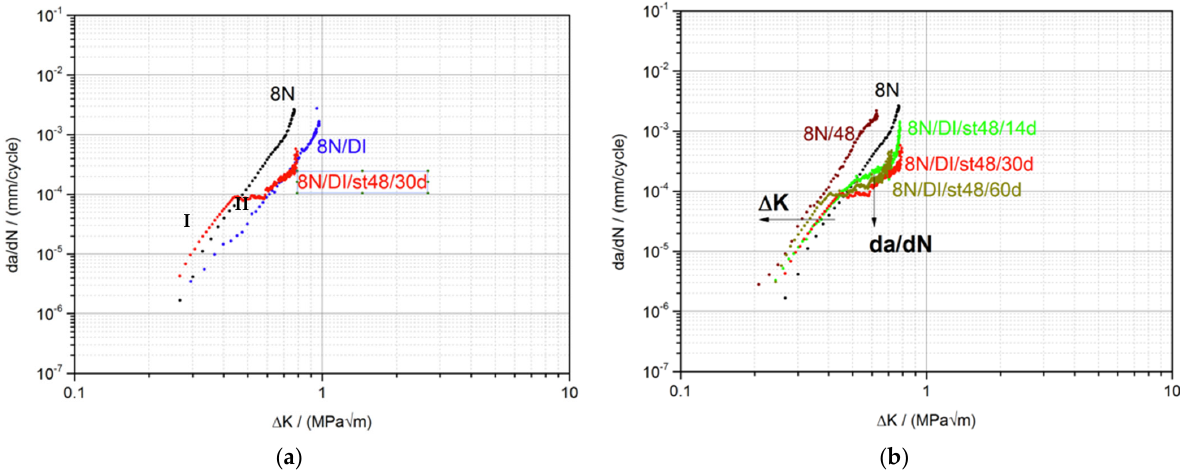
Figure 5. ESC behavior of PMMA after prior immersion and in situ wetting in DI ( a ) and influence of immersion time in DI on the fatigue crack growth behavior of PMMA ( b ).